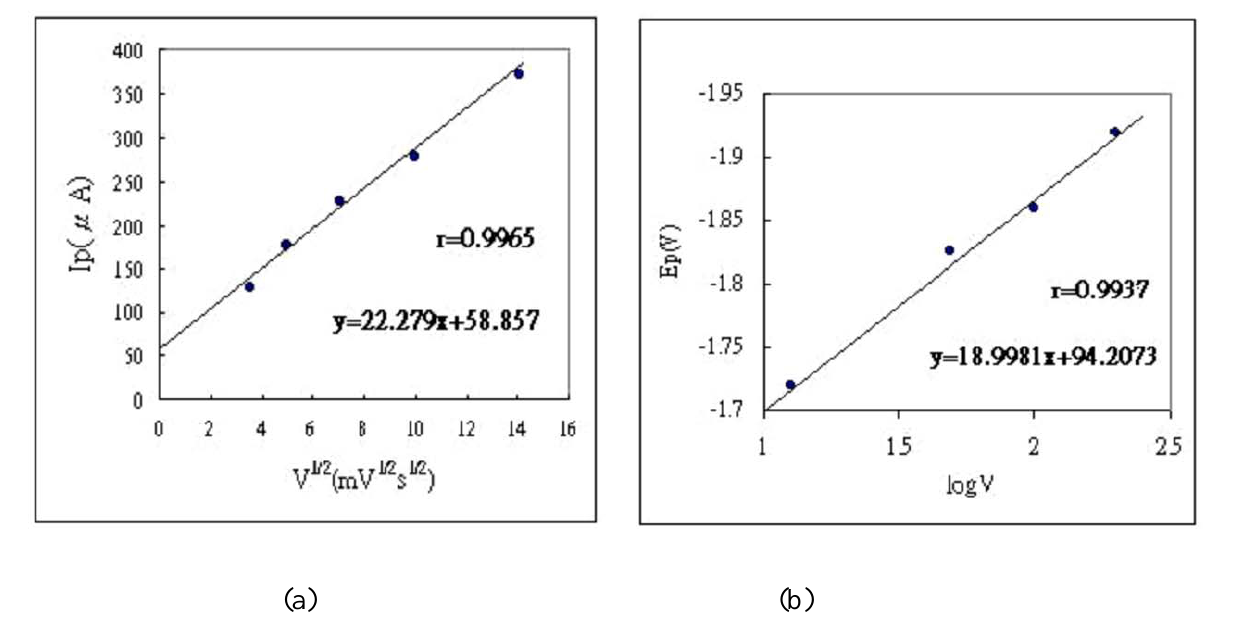
, as a function of the square root of the scan p